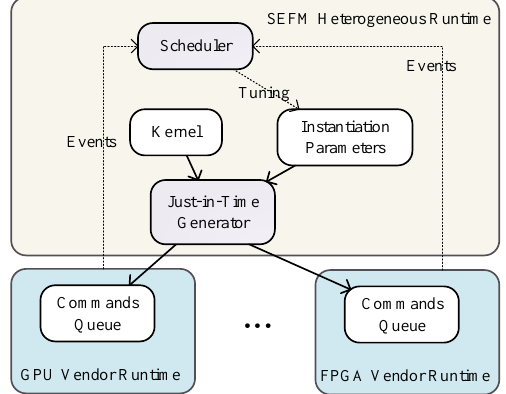
Figure 6. Heterogeneous OpenCL runtime architecture of FLIA.